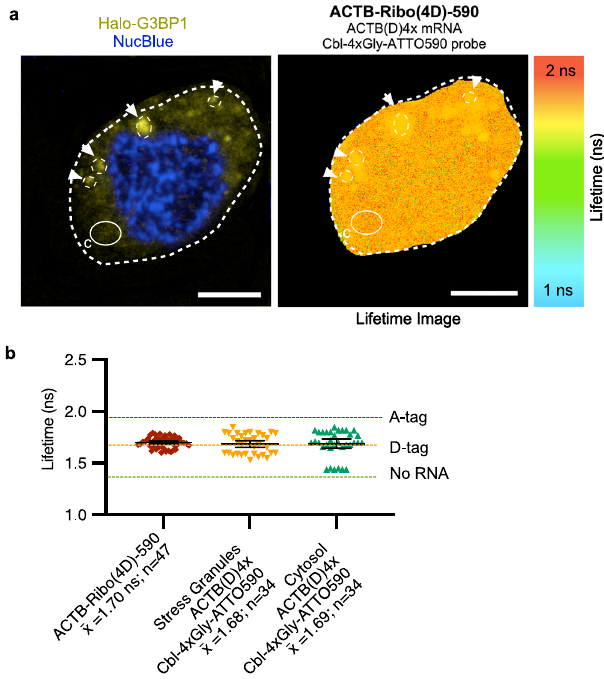
Fig. 5 | Visualizing RNA recruitment to stress granules (SGs) live via Riboglow- tagging and detection by FLIM. a Representative cell of arsenite-stressed Halo- Tag-G3BP1 U-2 OS cells transfected with ACTB-Ribo(4D) − 590. Cells were co- transfectedwitha fl uorescenttransfectionmarkertoidentifywhichcellshadtaken up the plasmid encoding for the Riboglow-tagged reporter, Riboglow probe was loaded into live cells. The chromosomally encoded SG marker protein G3BP1 tag- gedwithHaloTagwaslabeledwiththeHaloTagligandJF646live.Left:Fluorescence intensity image to visualize nucleus (blue) and SGs (yellow); white arrow = G3BP1- labeled SGs (scale bar = 10 μ m). Right: Pixel-by-pixel component lifetime image. Regions of interest (ROI) of SGs identi fi ed via G3BP1 in the intensity image (left) were labeled in the lifetime image (right) for further analysis. b The average fl uorescence lifetime value was determined for the whole cell and individual ROIs corresponding to each SG. White arrows pointing to circles in panel a and a ran- domly selected ROI of similar area in the cytosol (labeled with “ C ” in panel a ) illustrate the ROIs for dot plot analysis (65 cells, 115 ROIs, 5 total independent experiments). Dotted lines represent the mean of the lifetime for benchmarks established from ACTB tagged mRNA in Fig. 3. One-way ANOVA (95% con fi dence limit); post hoc test (Tukey HSD). Error bars indicate mean and standard devia- tion (+/ − SD).